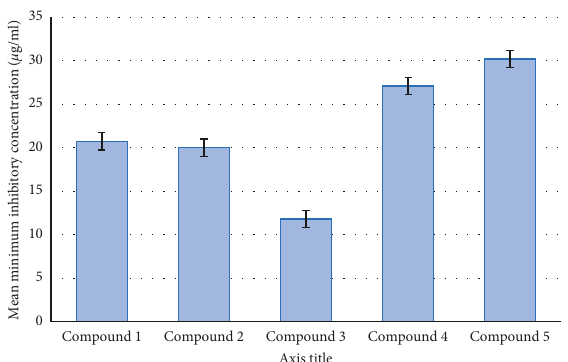
mL − 1 of the five tested compounds ·